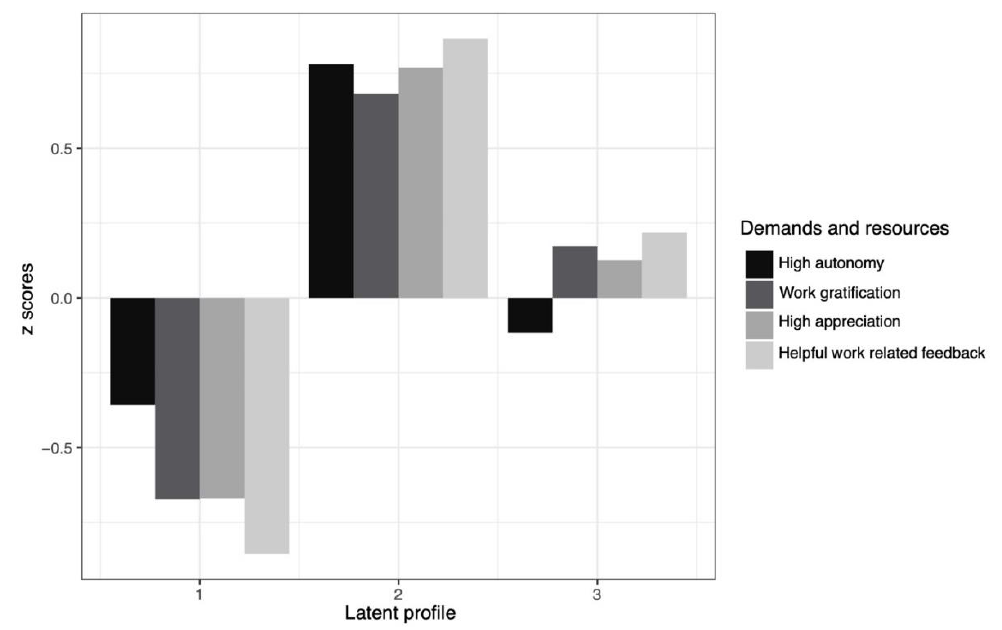
Figure 5. Latent profile solution for demands and resources (z-scores: high autonomy, work gratification, high appreciation, helpful work-related feedback)